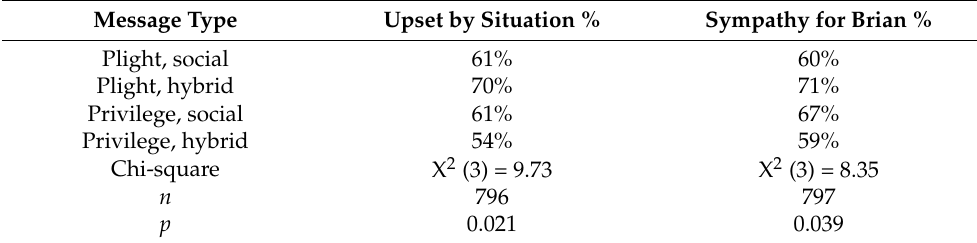
Table 3. Indicators of upset and sympathy for health inequities